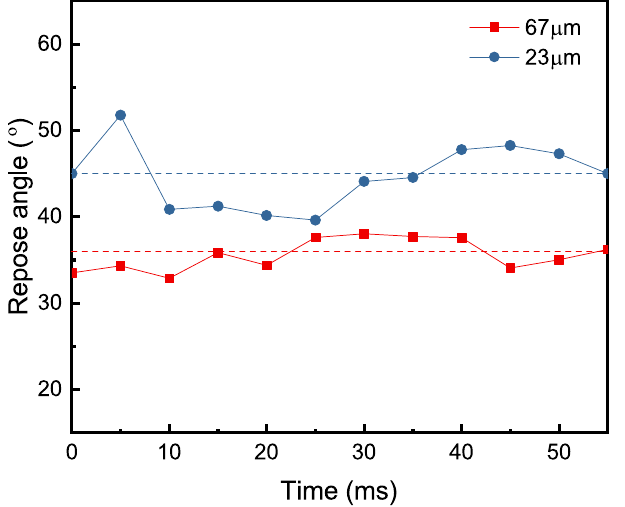
Figure 3. Dynamic repose angle “ α ” versus time during the spreading of 316 L stainless steel powder with two different average powder diameters. A total of 12 measurements for each powder size was used. There is a time lapse of 5 ms between each measurement. The 316 L stainless steel powder with an average diameter of 67 µ m, showed an average dynamic repose angle of 36° with a standard deviation of 2°. The 316 L stainless steel powder with an average diameter of 23 µ m showed a higher average dynamic repose angle with a value of 45° and a standard deviation of